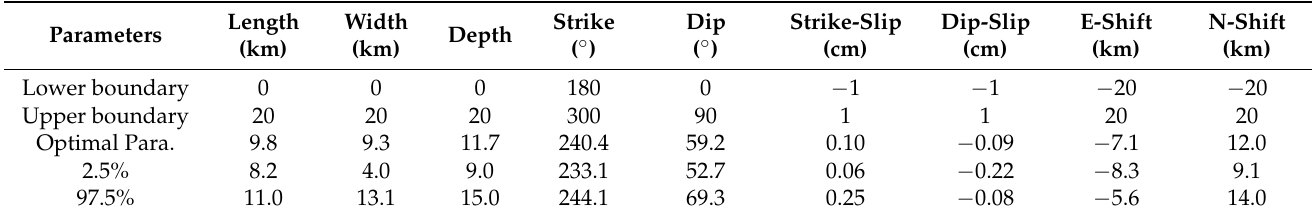
Table 3. The optimal solution and searching intervals of the fault geometry parameters in the non-linear GBIS inversion.